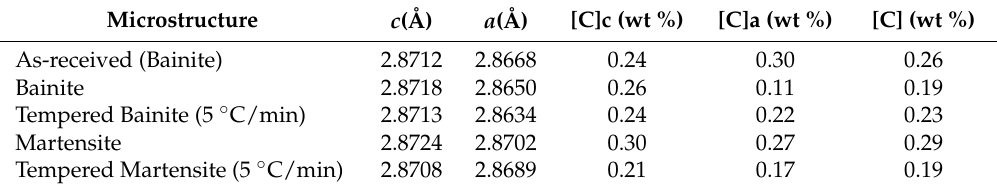
Figure 5. Two XRD (X-ray diffraction) peaks of bainite and martensite: ( a ) (110) peak and ( b ) (200) peak. Table 1. Lattice parameters and carbon contents of the as-received microstructure, bainitic ferrite, and martensite, before and after non-isothermal tempering with a heating rate of 5 °C/min, determined using X-ray diffraction.